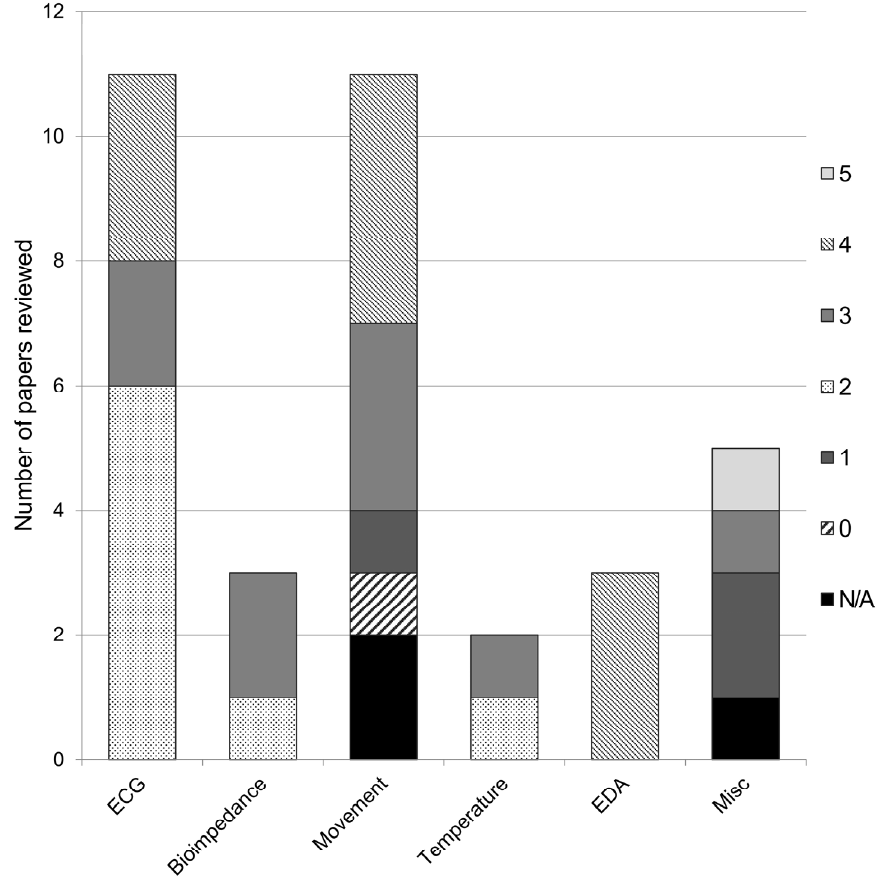
Figure 1. Summary of the reviewed studies by phenomenon measured (horizontal axis) and degree of textile integration (shading of the stacked